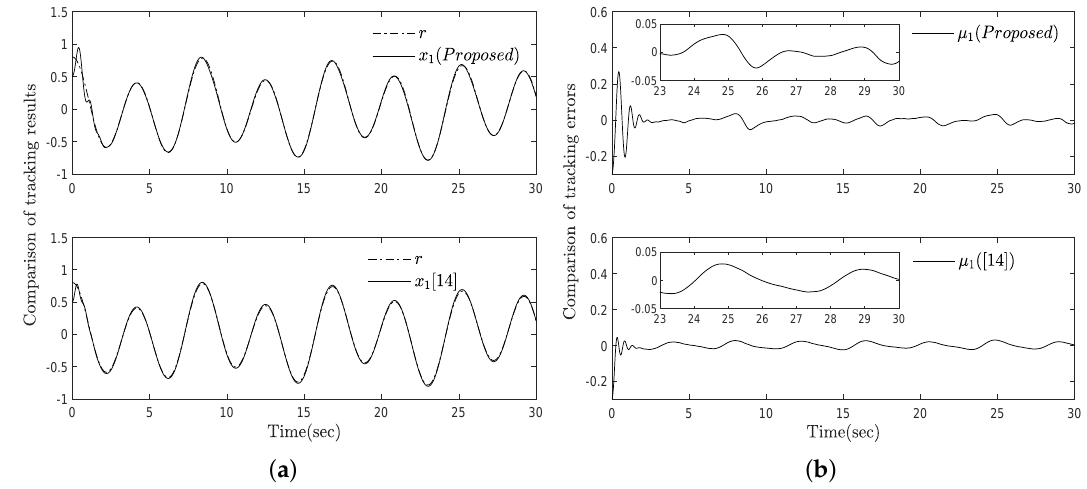
Figure 2. Comparison of tracking results and errors for Example 1 ( a ) x 1 and r ( b ) µ 1 .